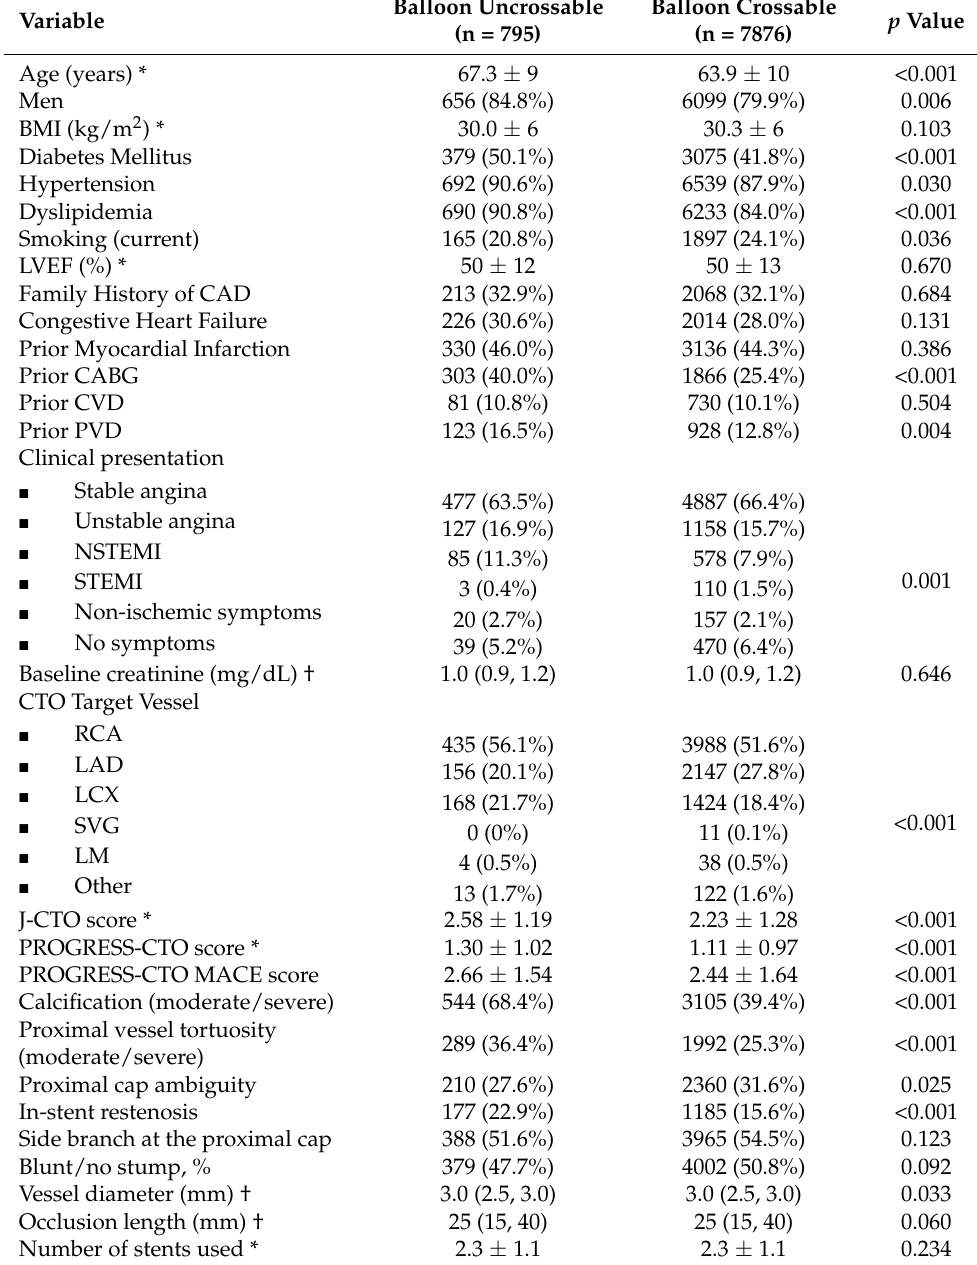
Table 1. Baseline clinical, angiographic, and technical characteristics of study patients with balloon uncrossable and balloon crossable lesions.